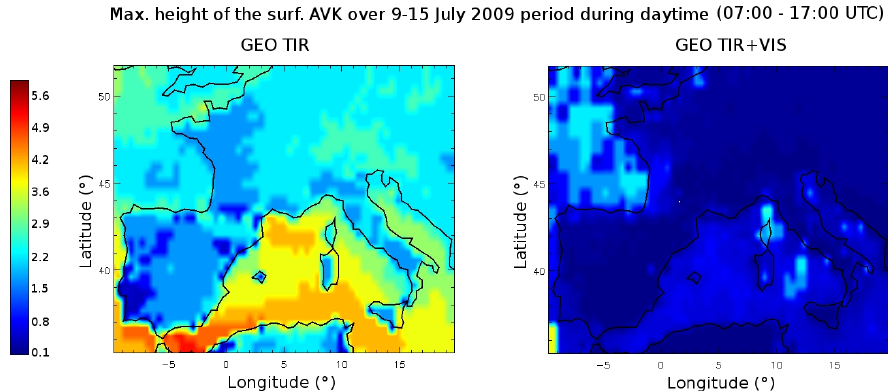
Figure 6. As in Fig. 5 but for the height (km) of the surface averaging kernels maximum. The colour bar indicates the different height value in km, with red/blue indicating relatively high/low